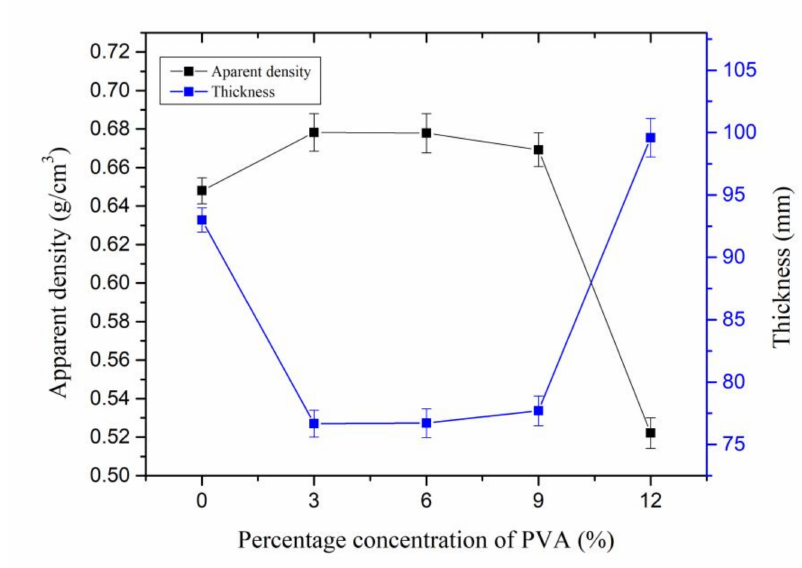
Figure 17. Thickness and density at di ff erent weight percentage concentration of